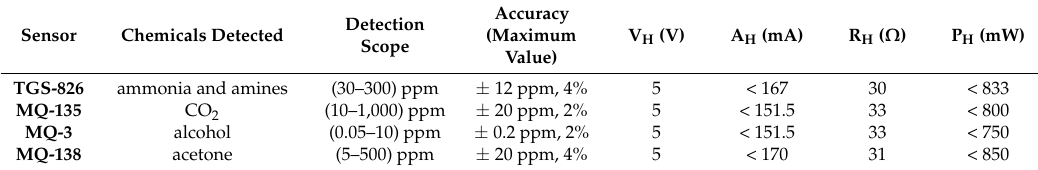
Table 3. Technical characteristics of the sensors selected.